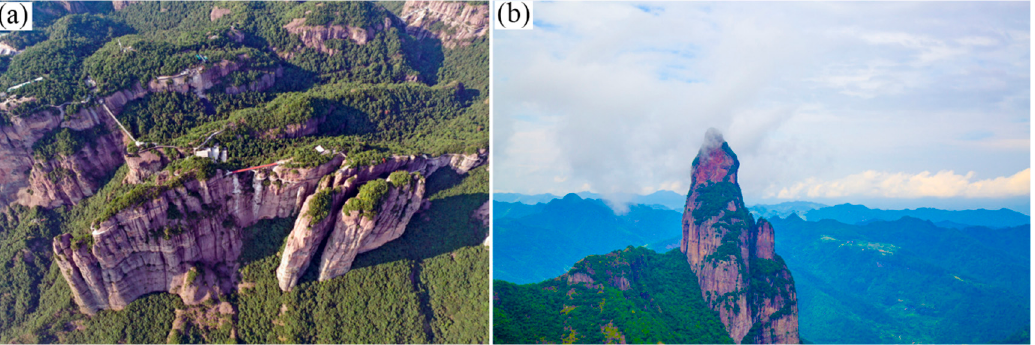
Figure 3. The beautiful landscapes in the Shenxianju Scenic Area, ( a ) Cliffs with a height difference of almost 700 m; ( b ) Rock spine like the Buddhism goodness Guanyin.